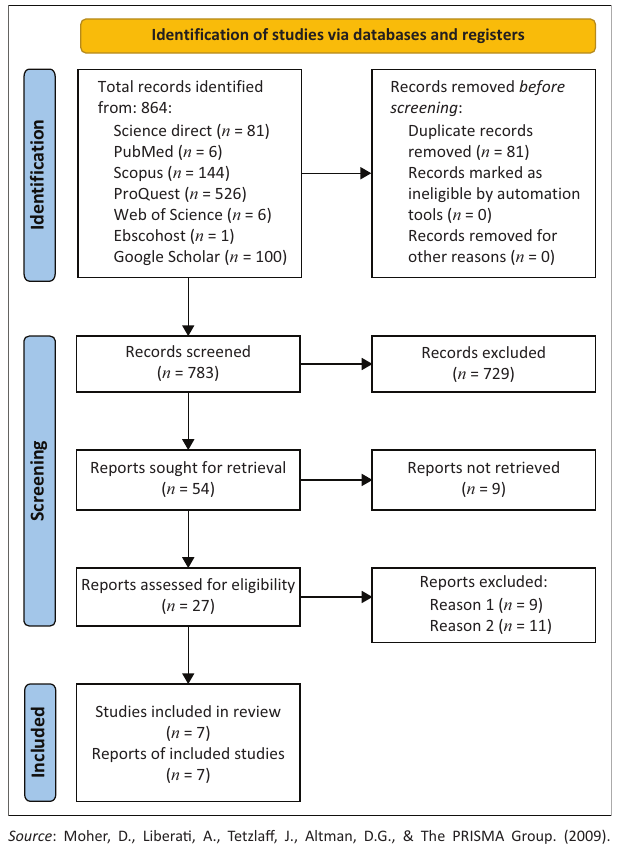
FIGURE 1: Preferred reporting items for systematic reviews and meta-analysis flow diagram for included